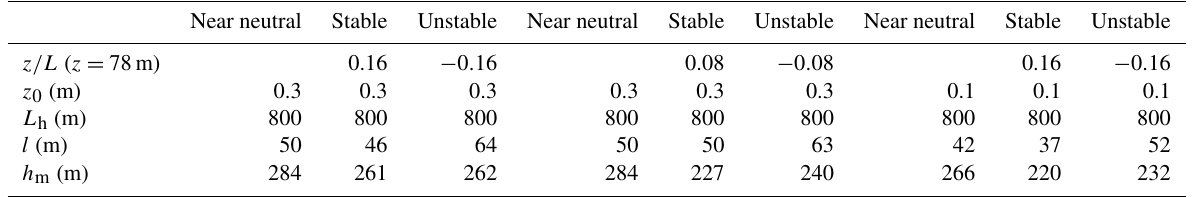
Table 1. Inner-layer ( l ) and medium-layer heights ( h m ) for southwesterly flow to the wind turbine at Perdigão (see Eqs. 1–7). Near neutral Stable Unstable Near neutral Stable Unstable Near neutral Stable Unstable z/L ( z = 78m) 0.16 − 0 . 16 0.08 − 0 . 08 0.16 − 0 . 16 0.3